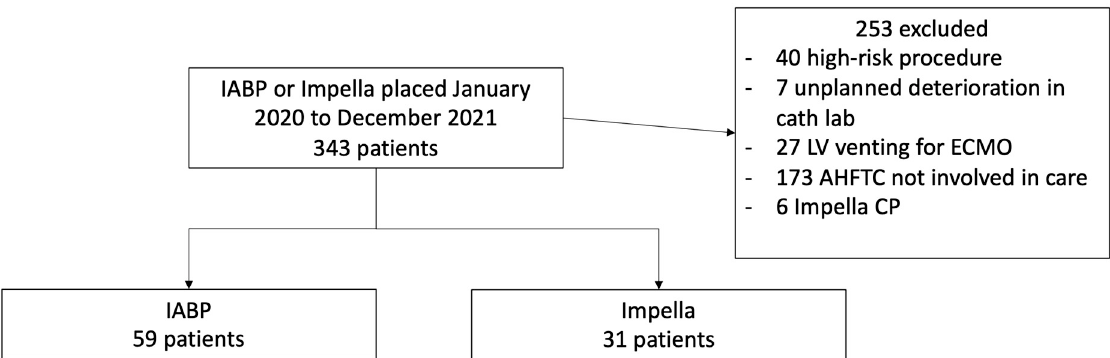
Figure 1. Cohort derivation flow chart. AHFTC, advanced heart failure and transplant cardiologist; IABP, intra-aortic balloon pump; ECMO, extracorporeal membrane oxygenation; LV, left ventricular; PCI, percutaneous coronary intervention.